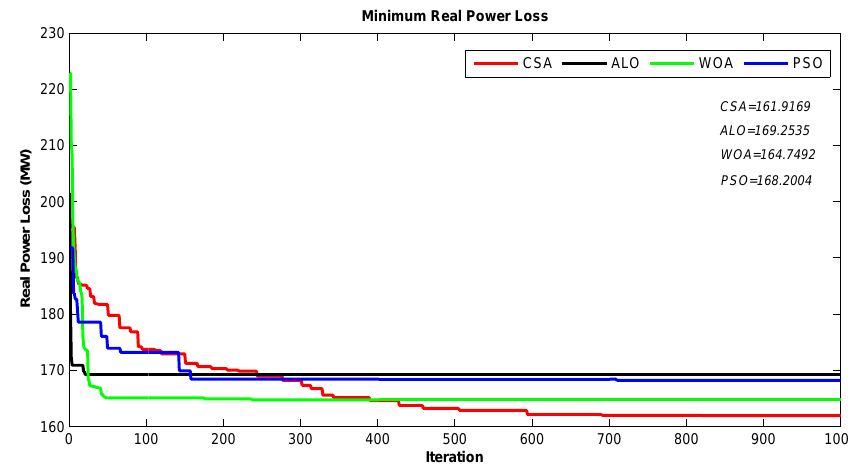
Figure 6. Performance loss convergence characteristics for Tunisian 86-bus system using PSO (blue), WOA (green), ALO (black) and CSA (red).